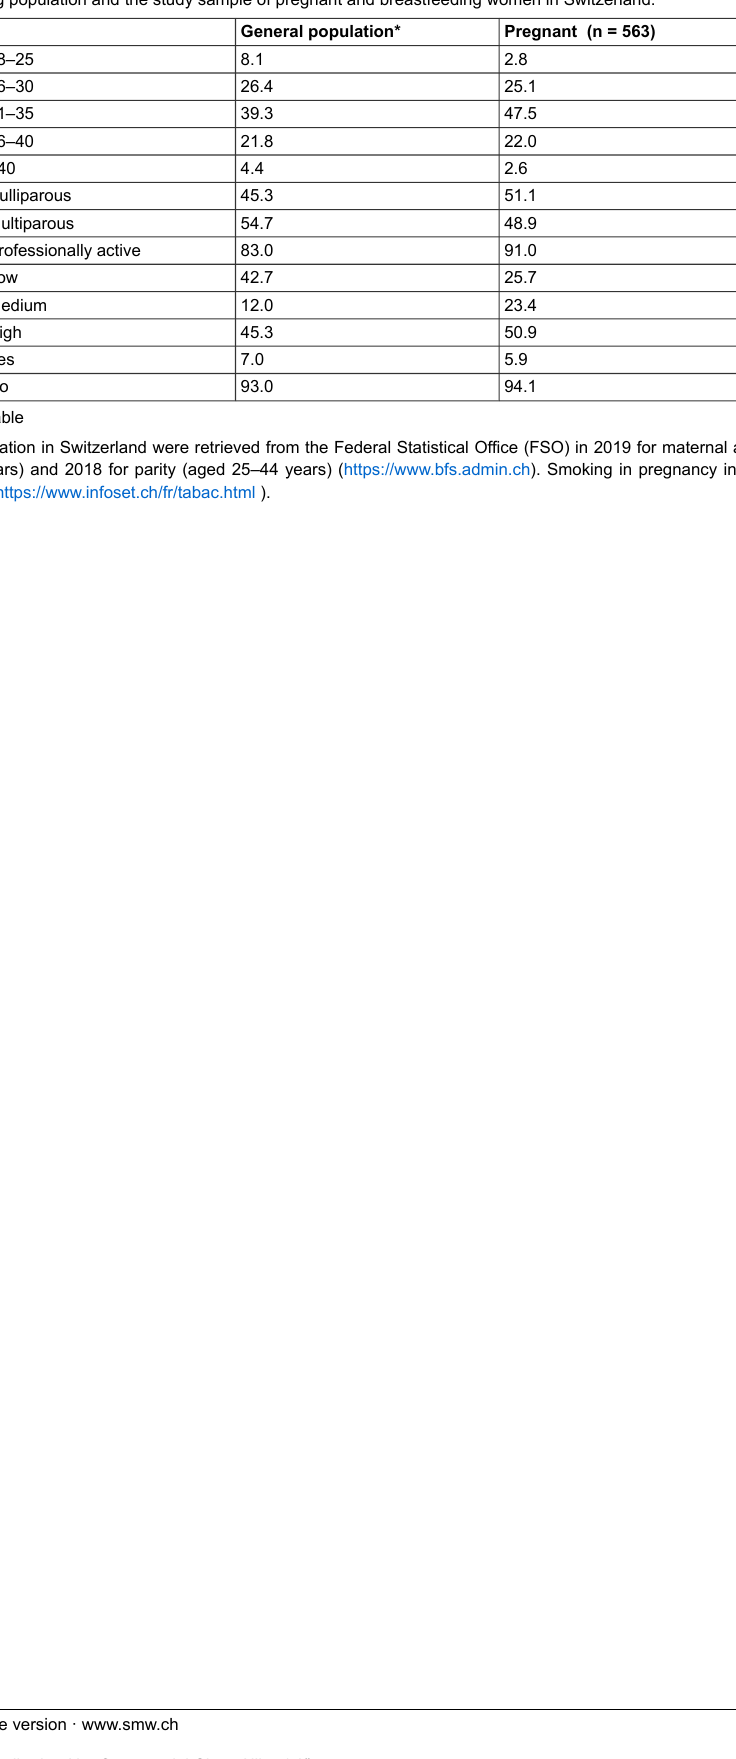
Table S1: Comparison between the general birthing population and the study sample of pregnant and breastfeeding women in